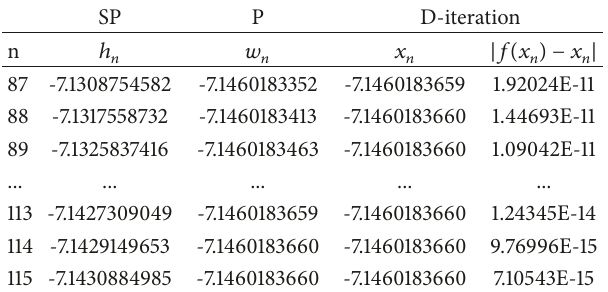
Table 5: SP-, P-, and D-iterations for 𝑓(𝑥) = (0.5) 𝑥 . SP P